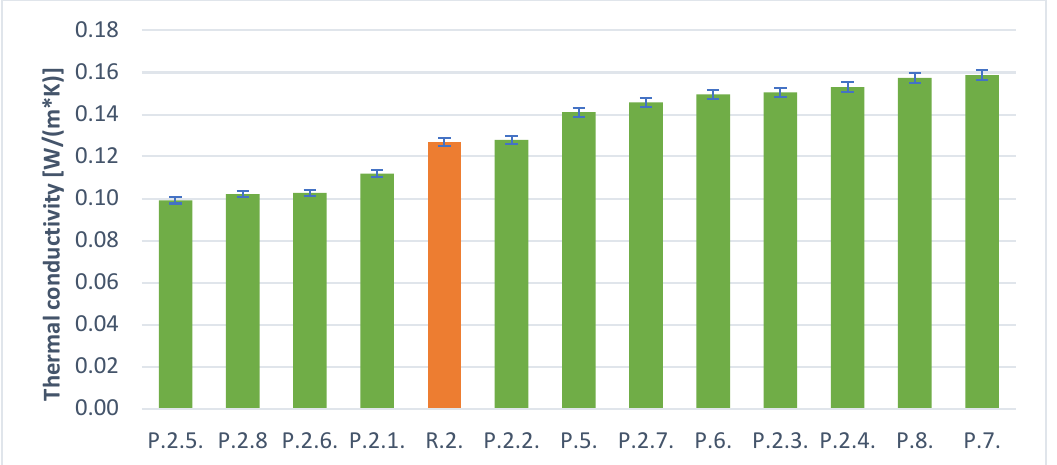
Figure 10. Thermal conductivity of the samples with hydrogen peroxide.